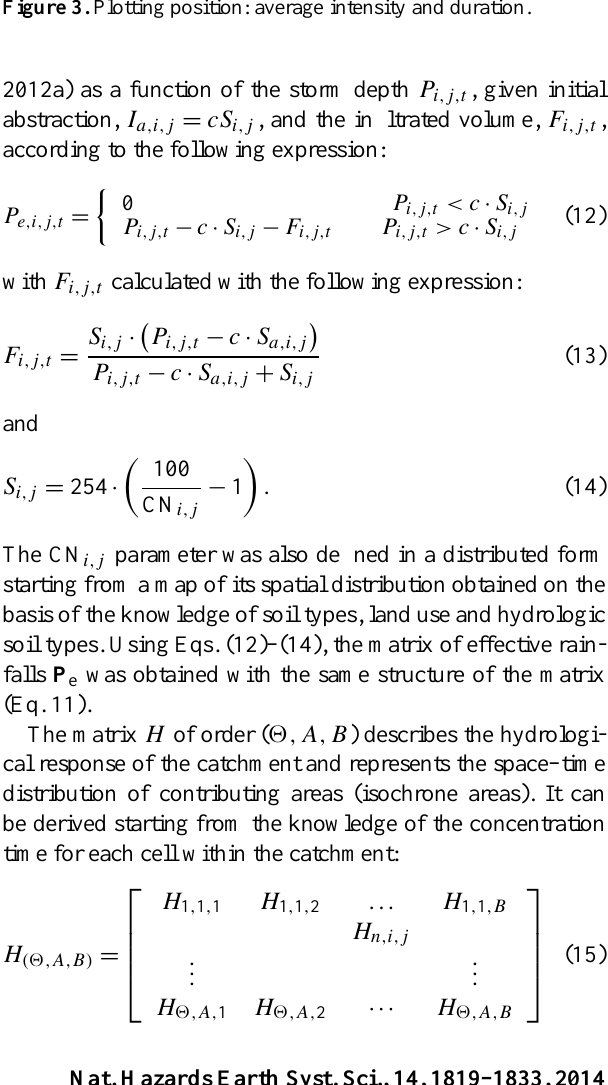
Figure 3. Plotting position: average intensity and